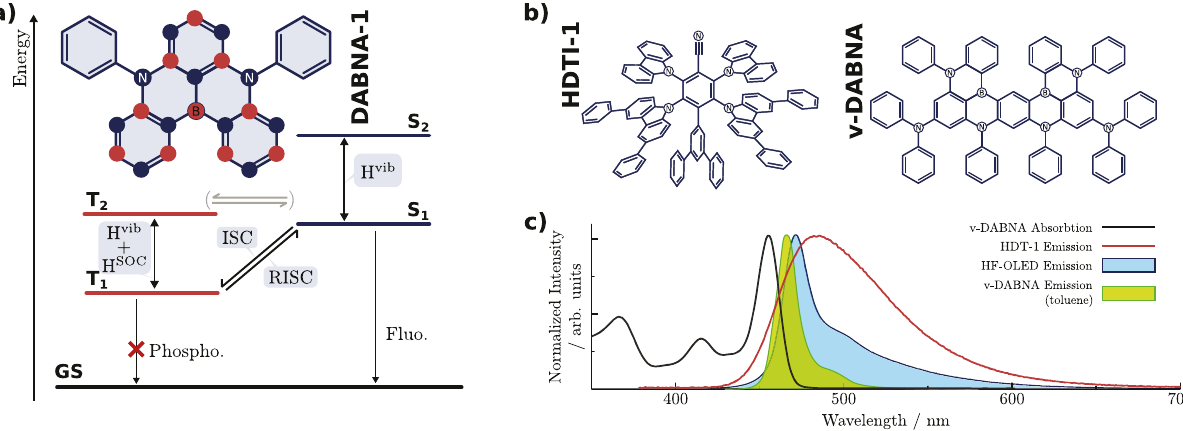
Fig. 2 Multi-resonance TADF Emitters. a TADF mechanism for the MR-TADF molecule DABNA 23 , involving vibronic coupling between multiple excited states similar to the D-A framework. The resonance effect is shown inset with the difference of density associated with the S 1 ← GS (T 1 ← GS) difference of electronic density: gain of electronic density in blue, loss in red. ISC Intersystem Crossing, RISC Reverse ISC, H vib Vibronic coupling, H SOC Spin-orbit coupling. b Structure of the HDTI-1 and v-DABNA used in the hyper fl uorescence OLED presented in 21 . c Absorption of v-DABNA (full black lines) 21 , emission of HDTI-1 (full red lines) 21 , emission of the hyper fl uorescence OLED device (blue line and blue area) 21 and emission of v-DABNA 25 (full green lines and green